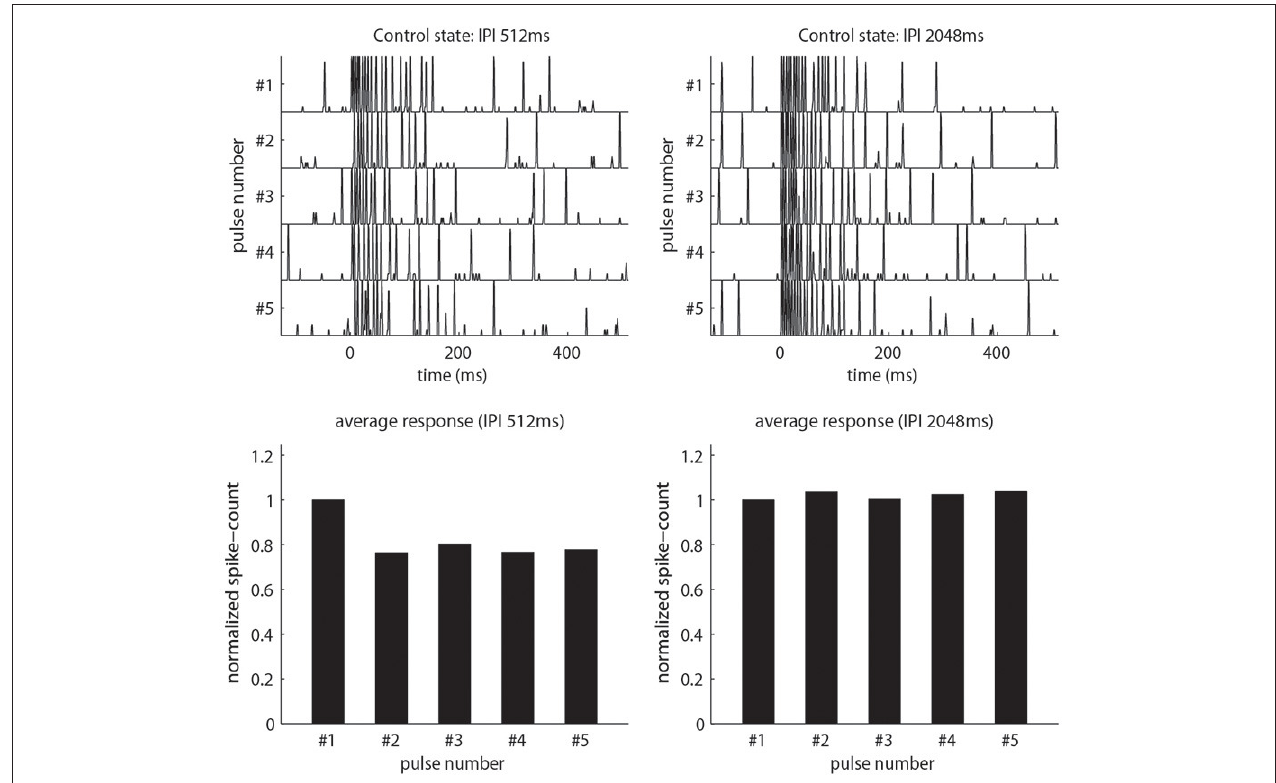
FIGURE 3 | Our model qualitatively reproduces the pulse-response attenuation seen in Figure 2. On top we show traces of PN-activity for a model glomerulus responding to a sequence of five pulses. On the bottom we show the normalized spike-count per-pulse. On the left we use an IPI of 512ms. On the right we use an IPI of 2048ms, which is significantly longer than the